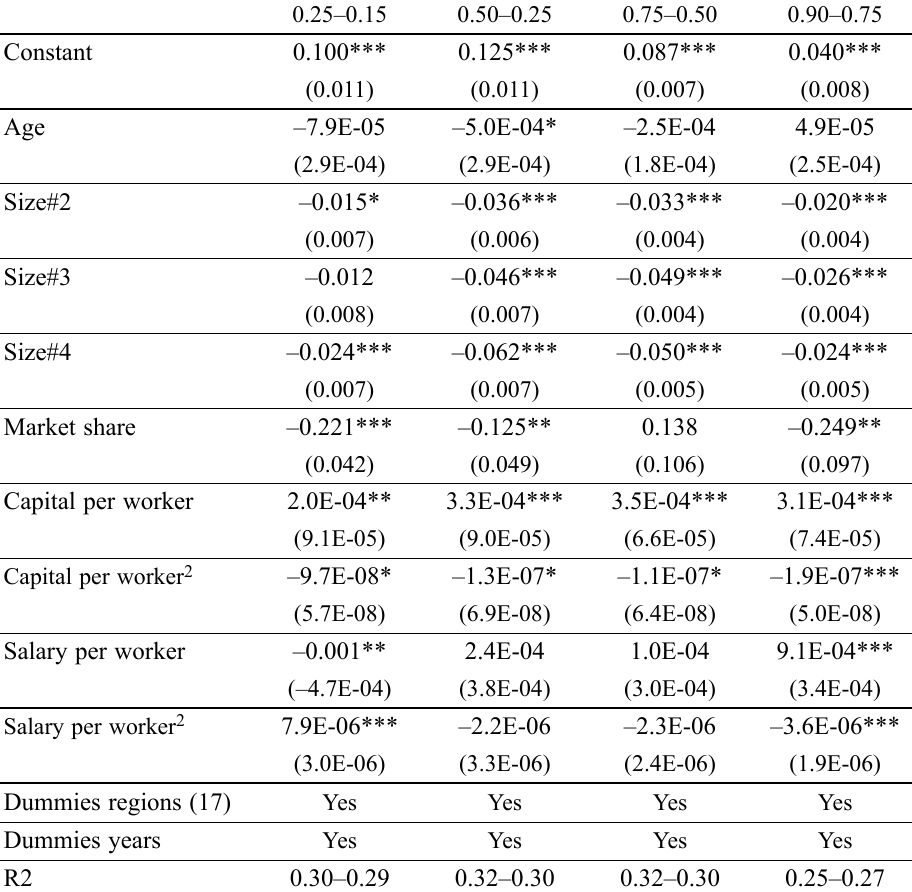
Table 4. Interquantile range regressions for comparison of quantiles